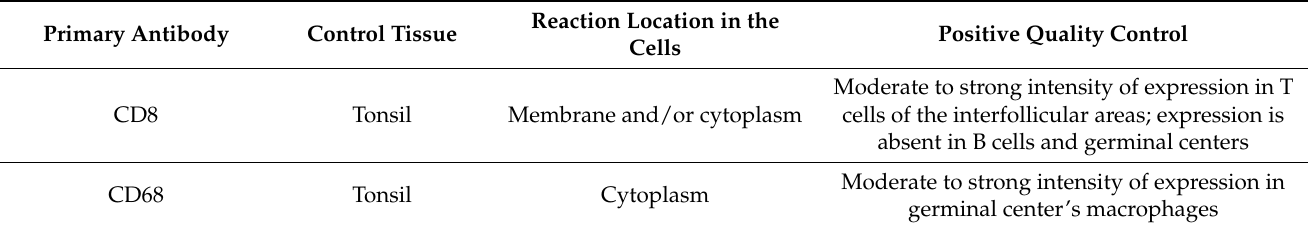
Table 3. External control tissues used and IHC expression pattern established for respective